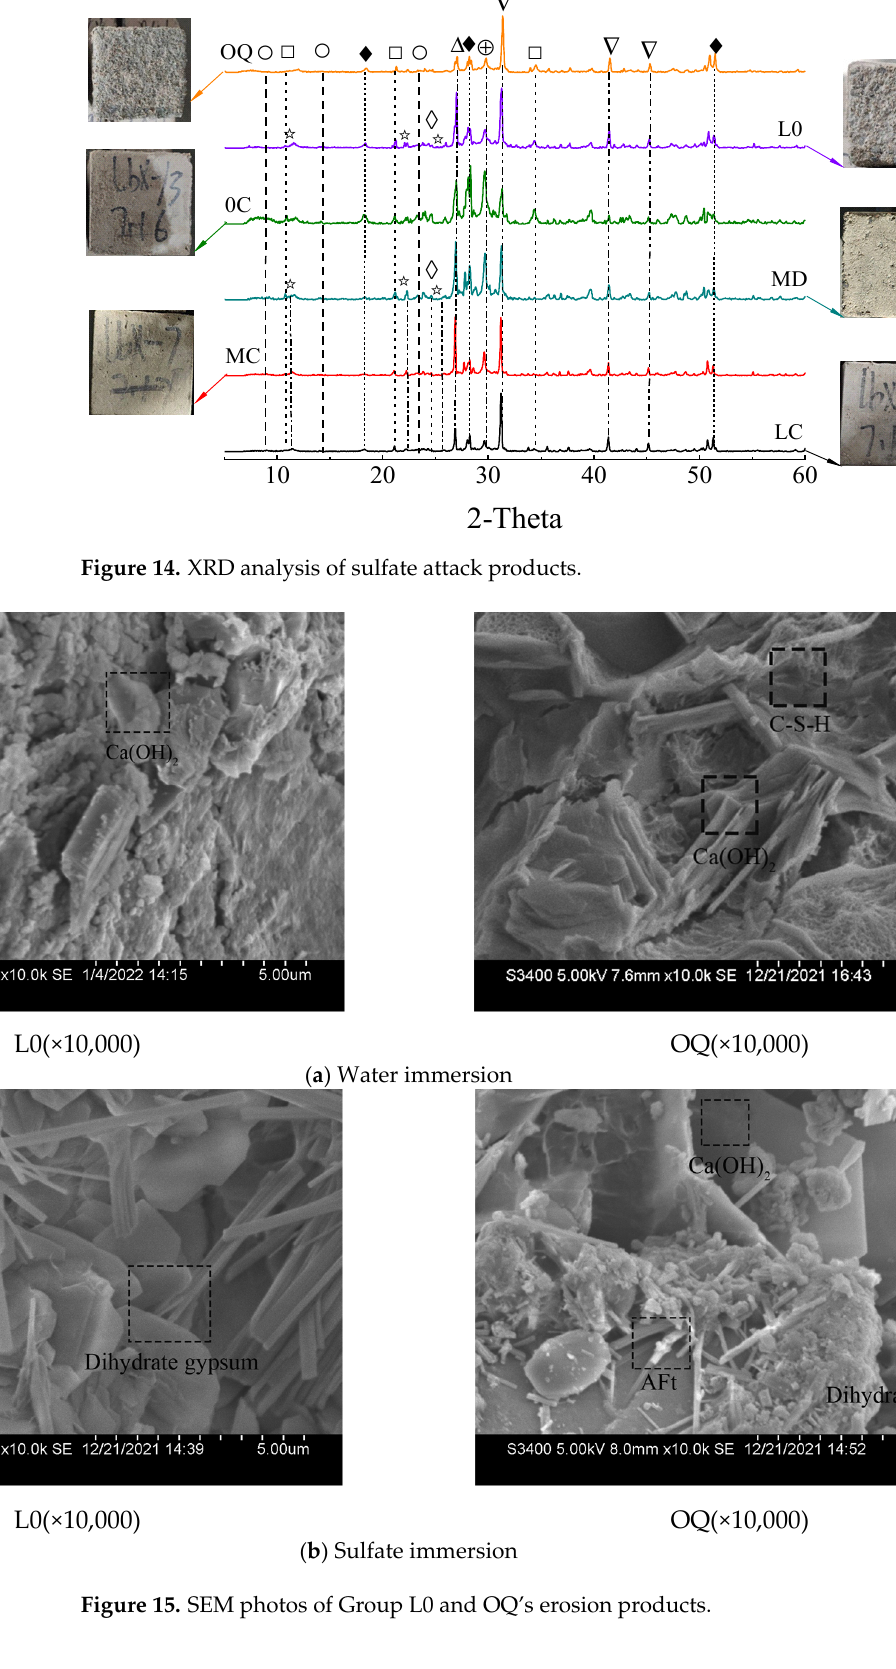
Figure 15. SEM photos of Group L0 and OQ’s erosion products.